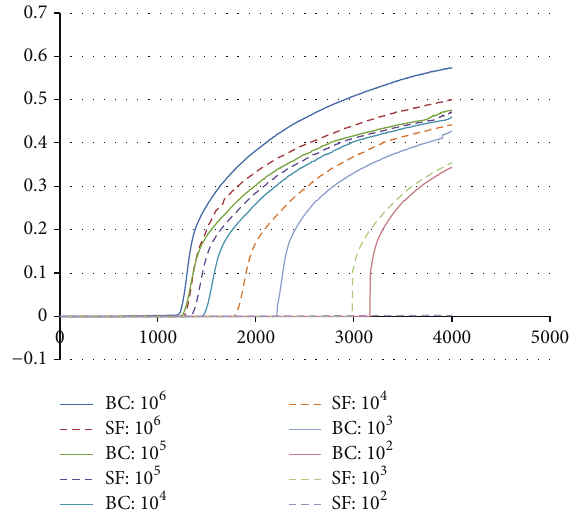
Figure 1: Sensitivity of LAMP assay of bacterial culture (BC) and spiked faecal (SF) specimens on different CFU (from 10 6 to 10 2